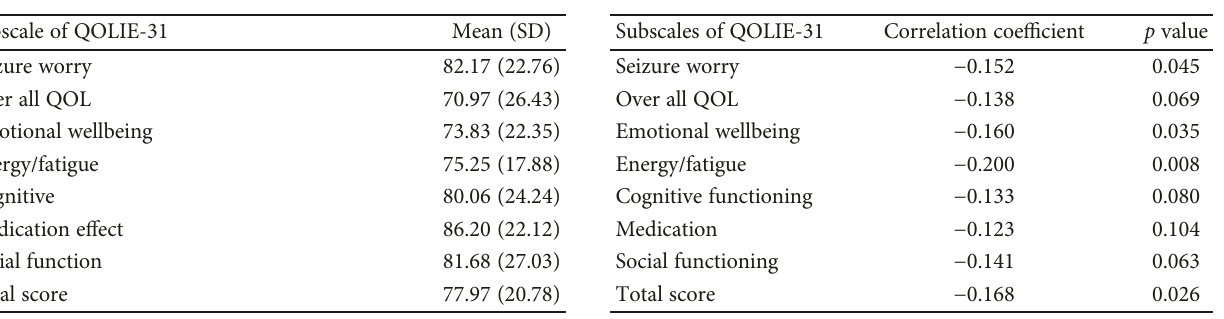
Table 4: Correlation between number of seizure and total score of QOLIE-31 subscale in ACSH and Mekelle Hospital.